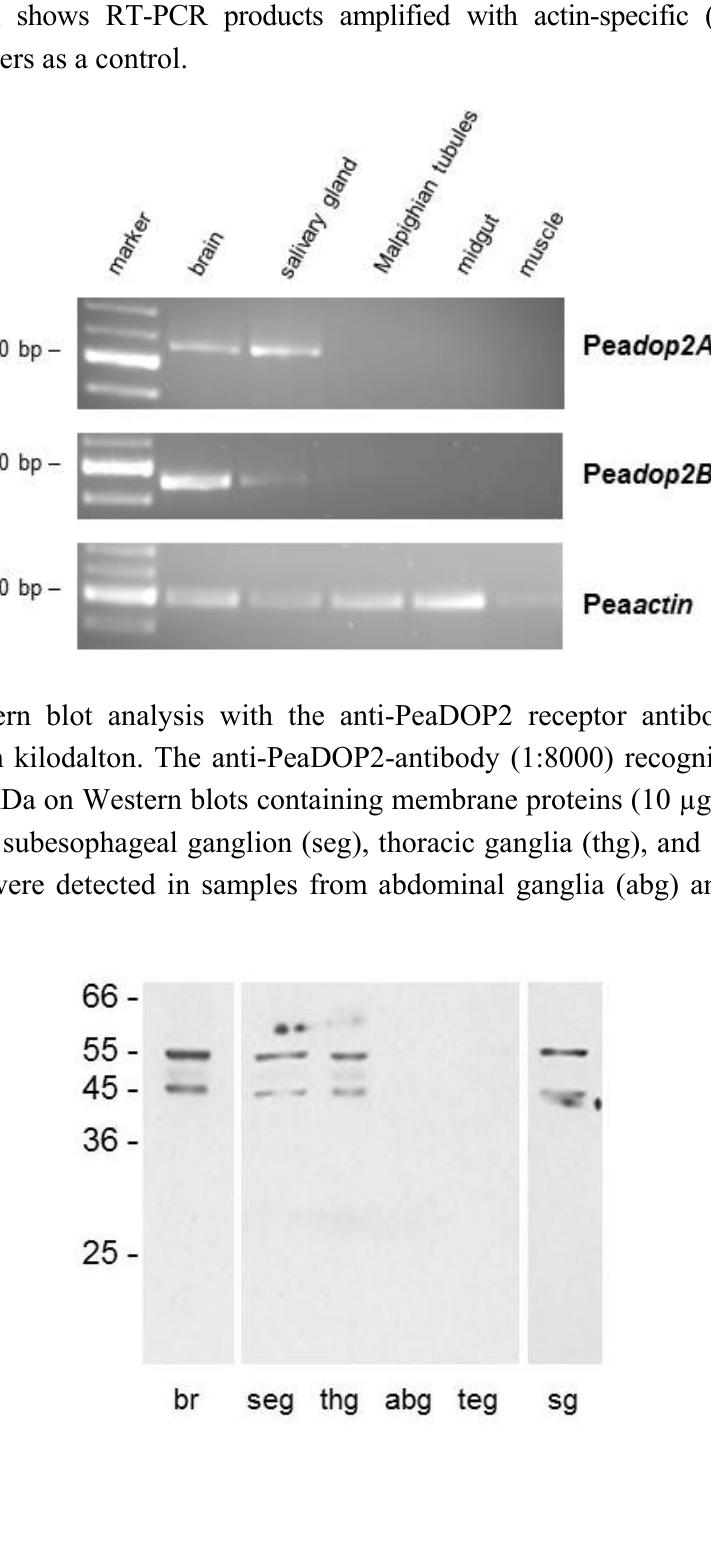
Figure 3. Tissue distribution of Peadop2A/B mRNA. A 100 bp DNA ladder (marker) is shown on the left. Detection of PCR products amplified on total RNA isolated from brain, salivary glands, Malpighian tubules, midgut, and leg muscle. Amplification failed when samples were digested with an RNase cocktail prior to RT-PCR (data not shown). The lower panel shows RT-PCR products amplified with actin-specific (Accession No.